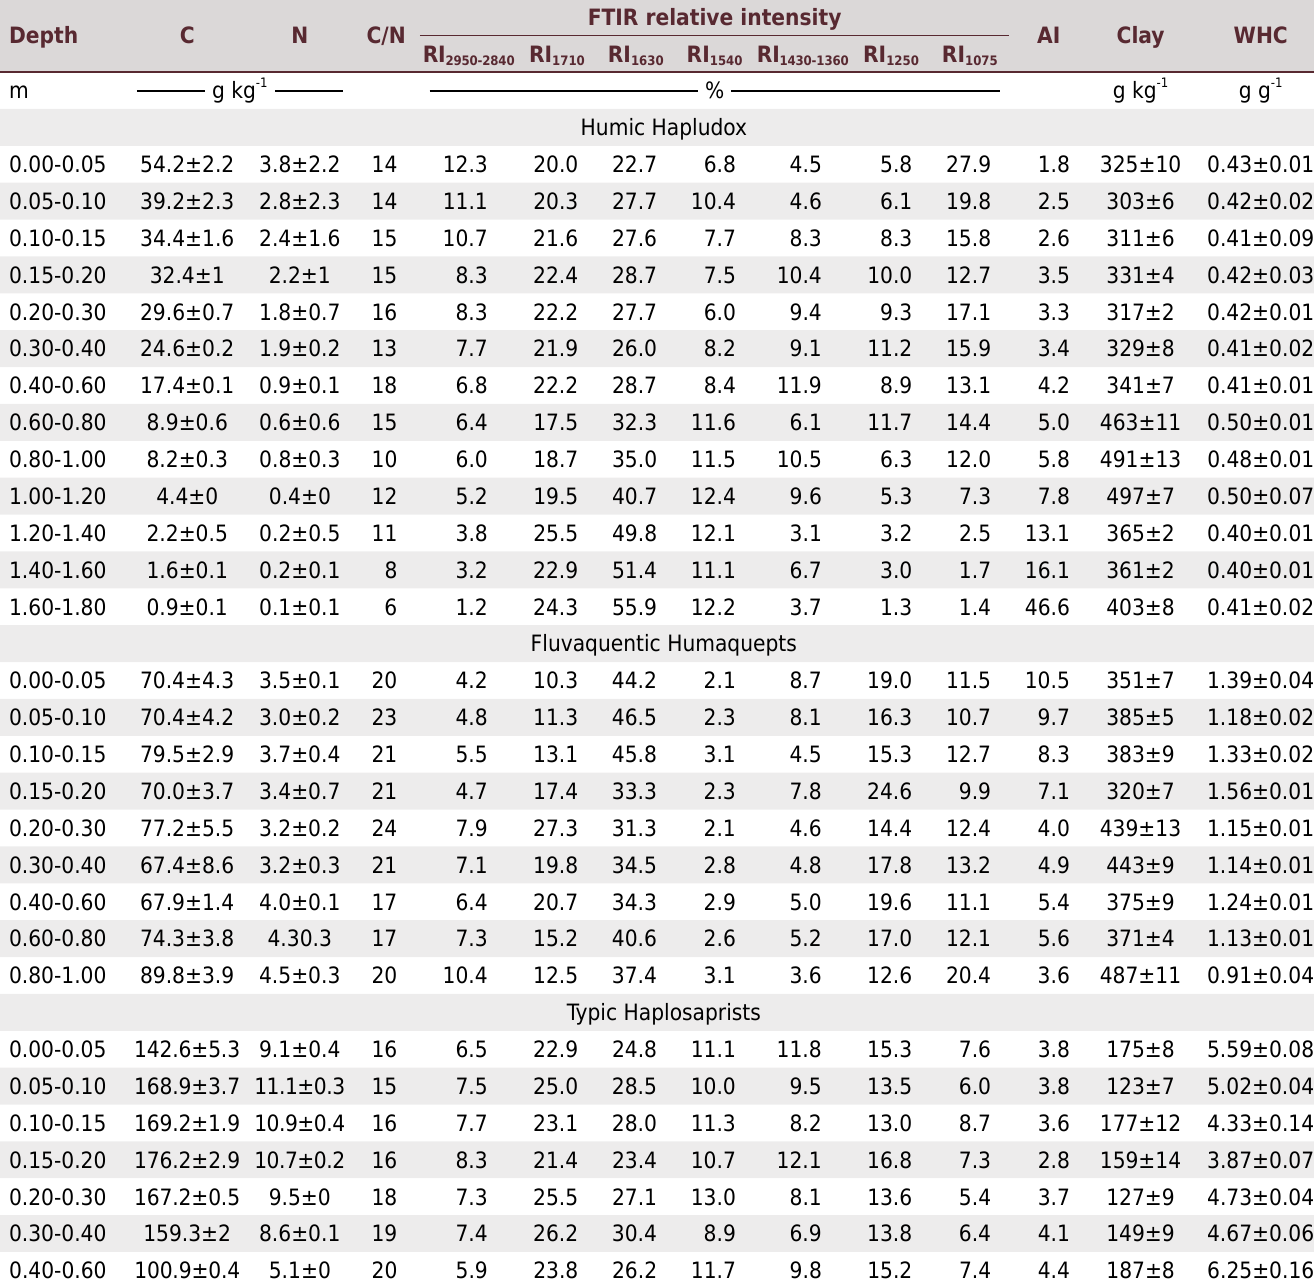
Table 1. Carbon and N content (mean±standard deviation), FTIR spectral relative intensities, aromatic index, clay content, and water holding capacity of three soils in a toposequence under Araucaria moist forest - Pinhais, PR, Brazil Depth